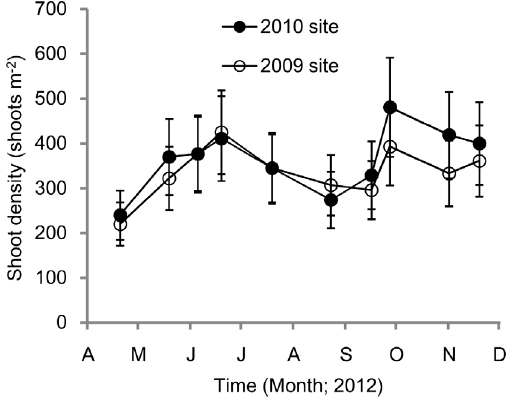
Figure 2. Variations in shoot density (shoots m 2 2 ) of Zostera marina at the 2009 and 2010 transplant sites. Values are means 6 SD. doi:10.1371/journal.pone.0092982.g002 PLOS ONE |